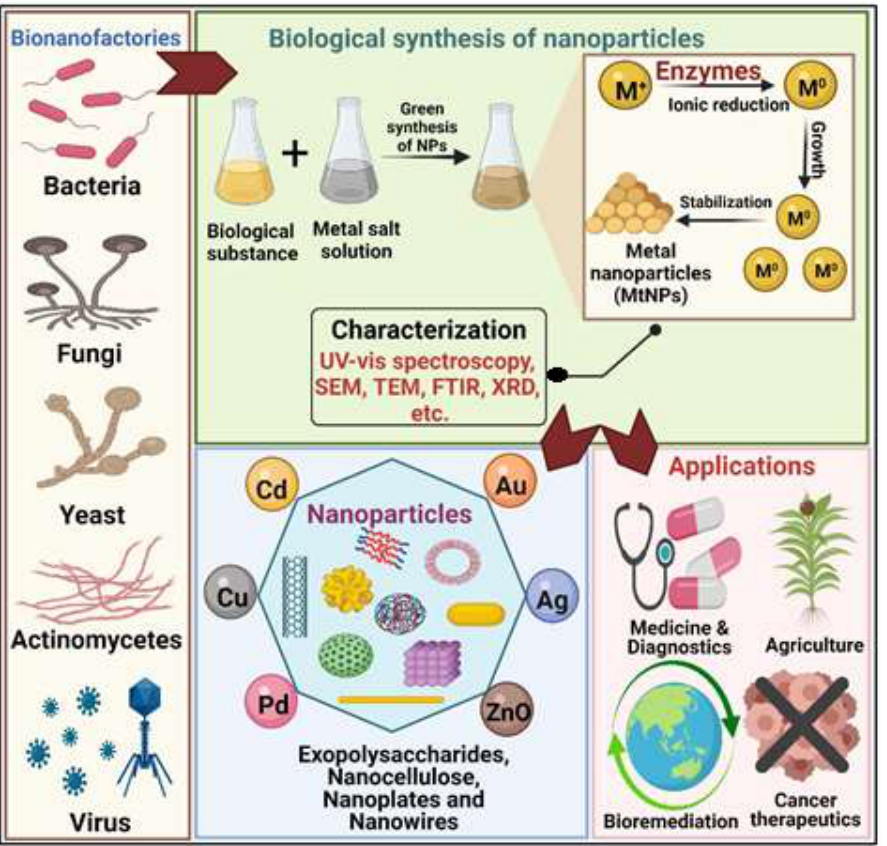
Figure 2. Depicts a schematic representation of the microbe-based biological synthesis of various nanoparticles, their characterization and applications.